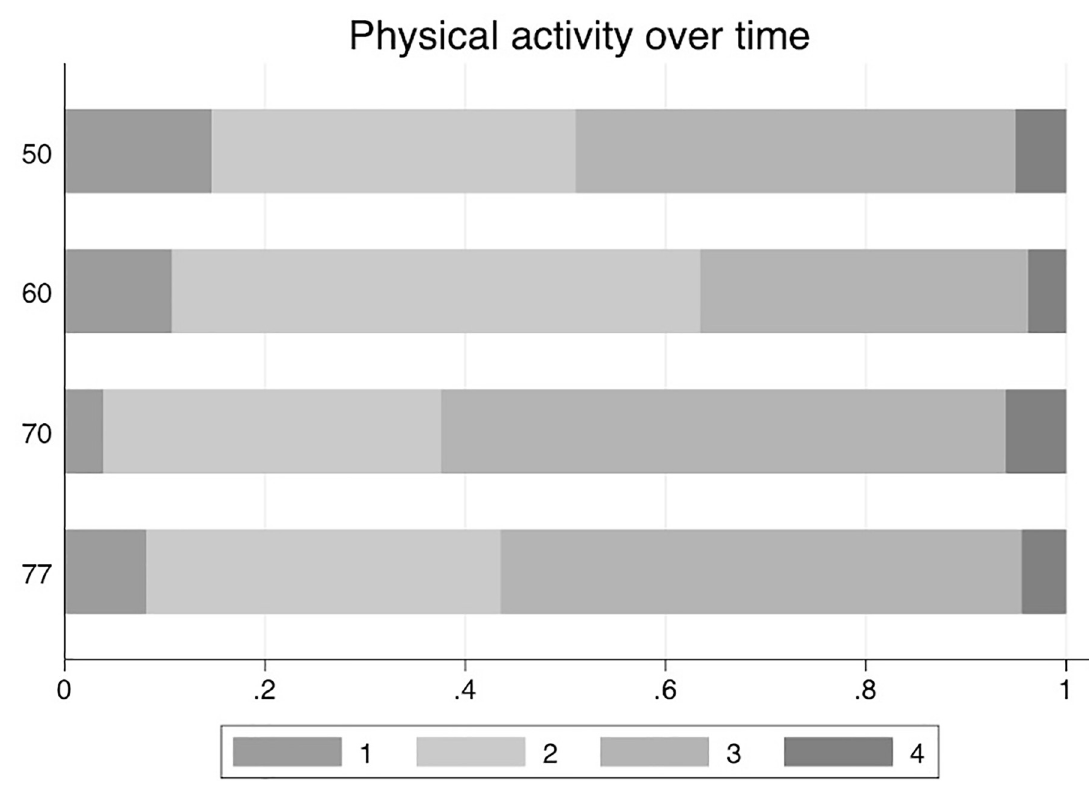
Fig 1. Proportions of the four levels of physical activity (PA) groups at the four different investigation cycles in the ULSAM- cohorts.